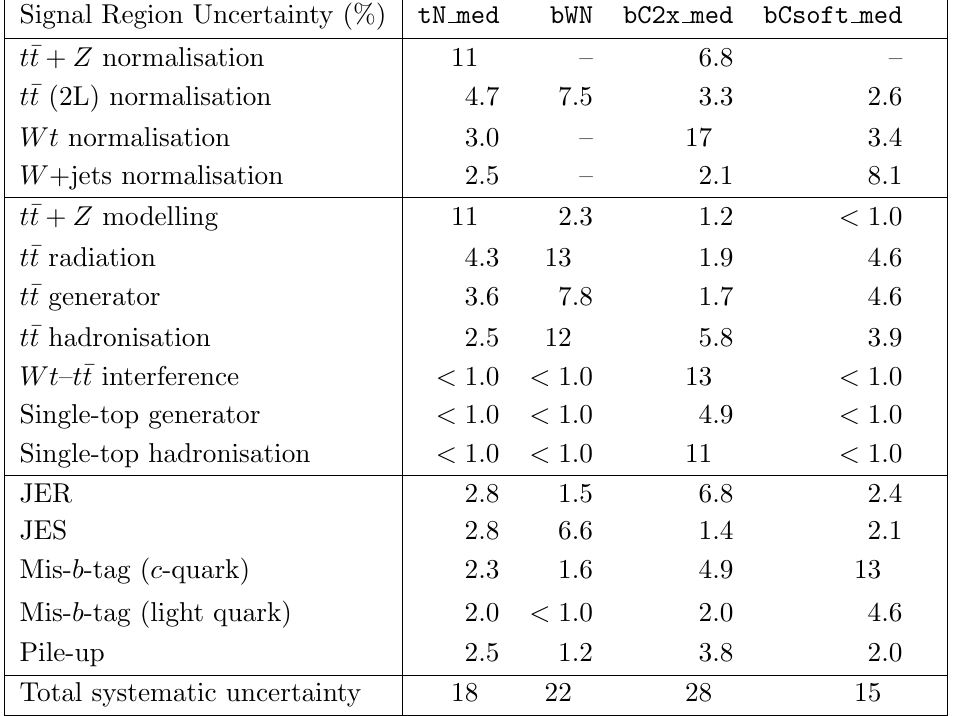
Table 22 . Summary of the dominant systematic uncertainties in the total predicted background yields, obtained by the background-only (cid:12)ts as described in section 10.1, in several representative signal regions: tN med , bWN , bC2x med , and bCsoft med . Numbers are given as percentages of the total background